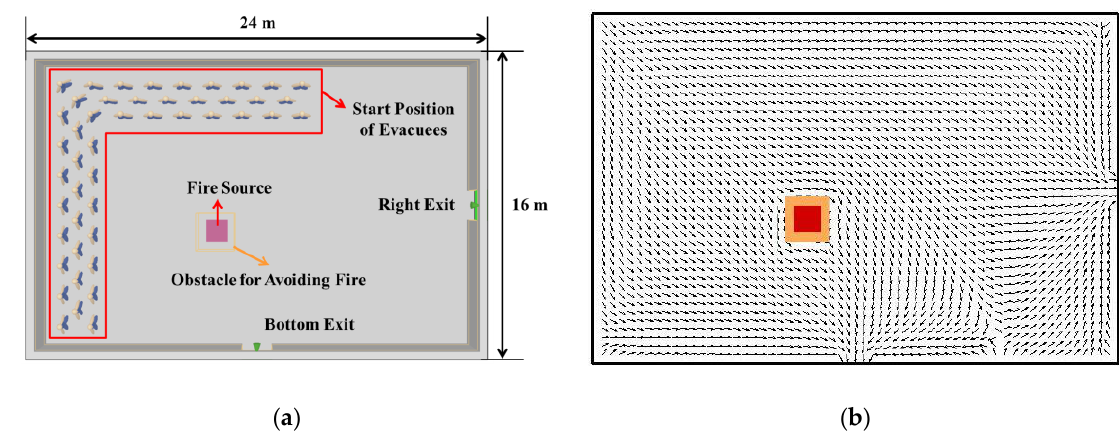
Figure 1. The ( a ) computational domain and ( b ) desired direction of every grid point.